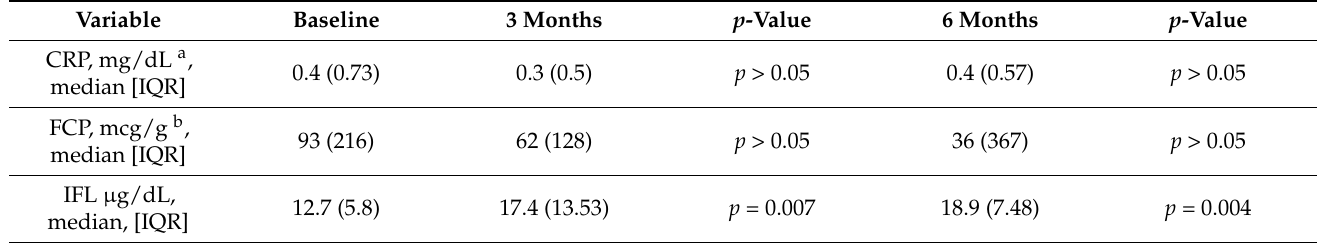
Table 3. Trends in biomarkers and infliximab trough levels in intensified